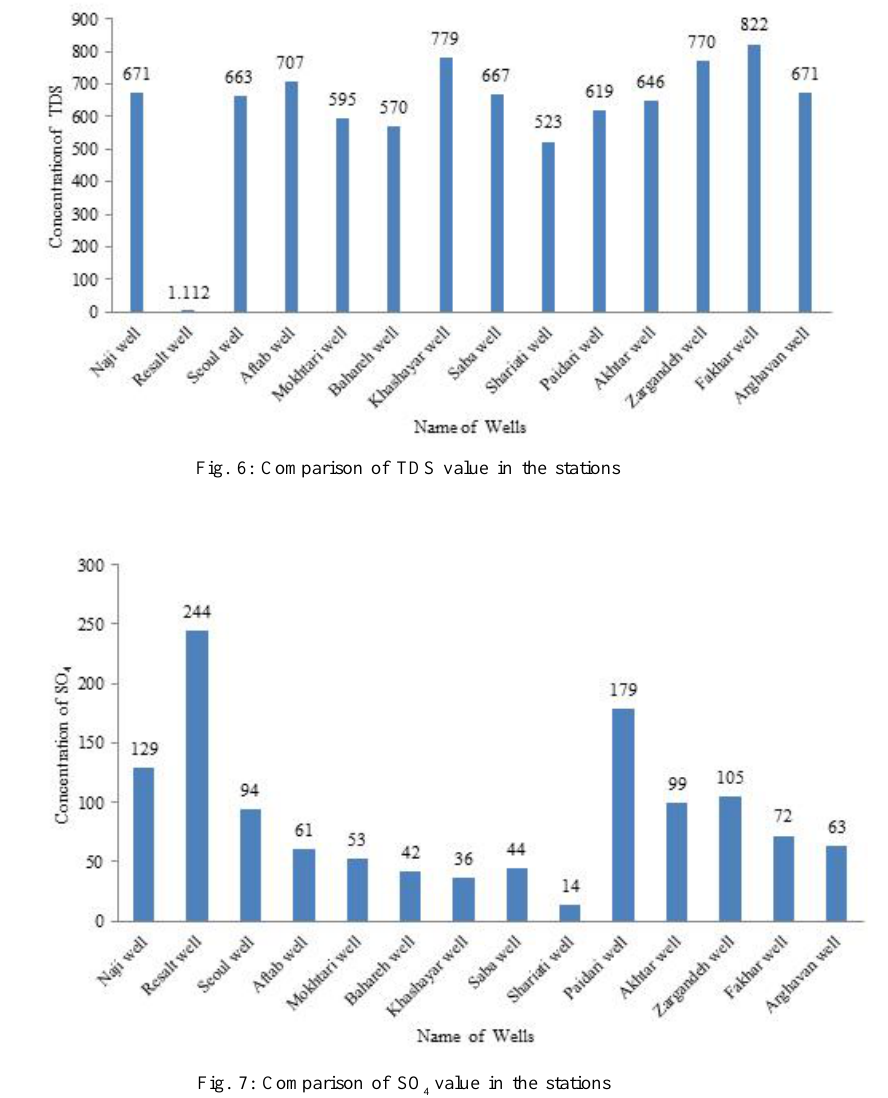
Fig. 7: Comparison of SO